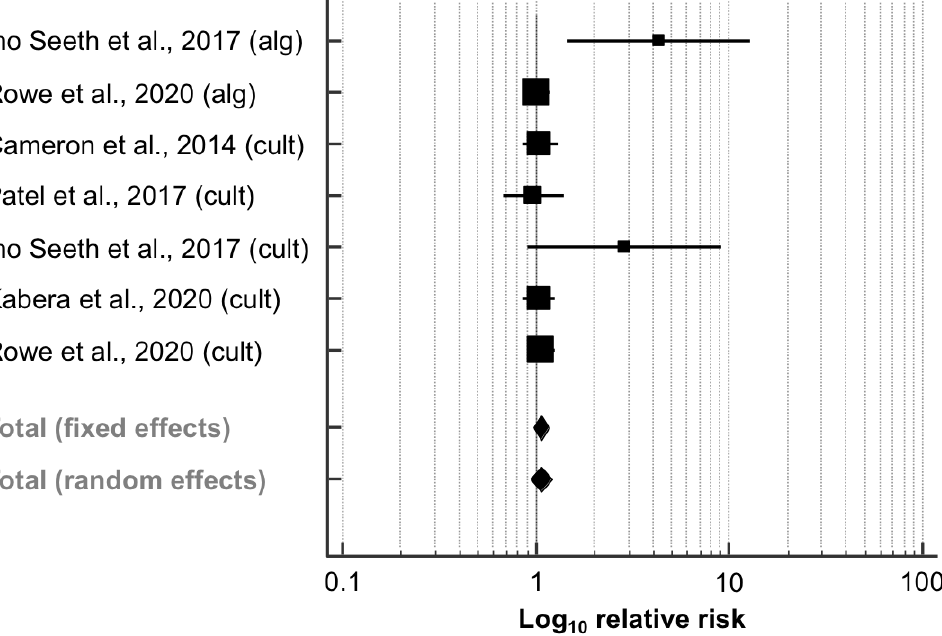
Figure 4. Effect of algorithm-guided (alg) and culture-based (cult) selective dry cow treatment (experimental group) compared to blanket dry cow treatment (control group) on the risk to have a new intramammary infection (IMI) after calving. See Figure 3 for remainder of key.